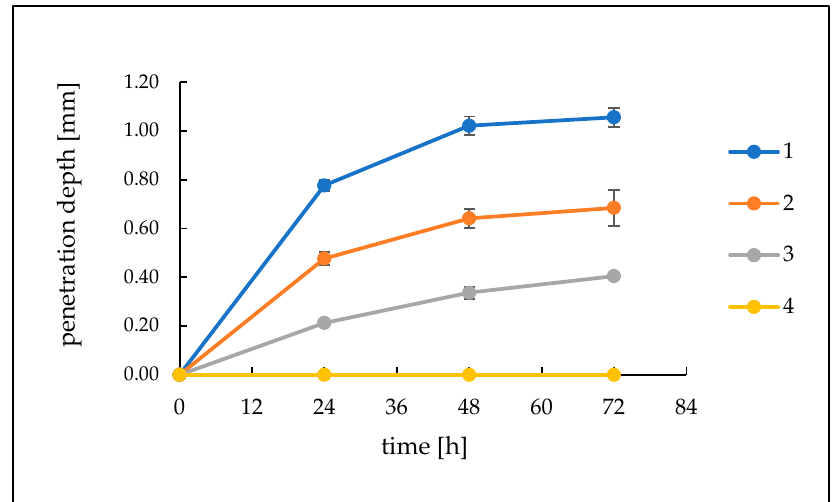
Figure 4. The course of changes in the thickness of the resulting layer of products on the surface of the model sebum over 72 h for Formulations (1–4).